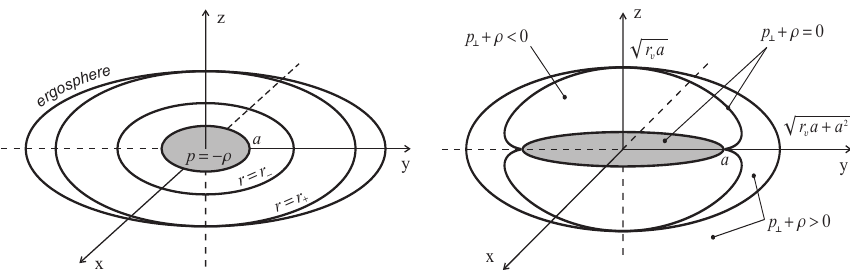
Figure 1. ( Left ) Horizons, ergosphere, and de Sitter vacuum disk for the first type of interior. ( Right ) Vacuum S -surface incorporating the de Sitter disk in the second type